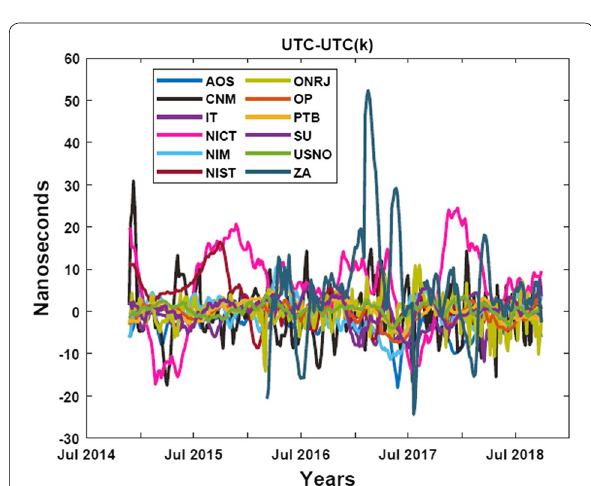
Fig. 10 Examples of the offset of some UTC(k) time scales versus UTC in the last